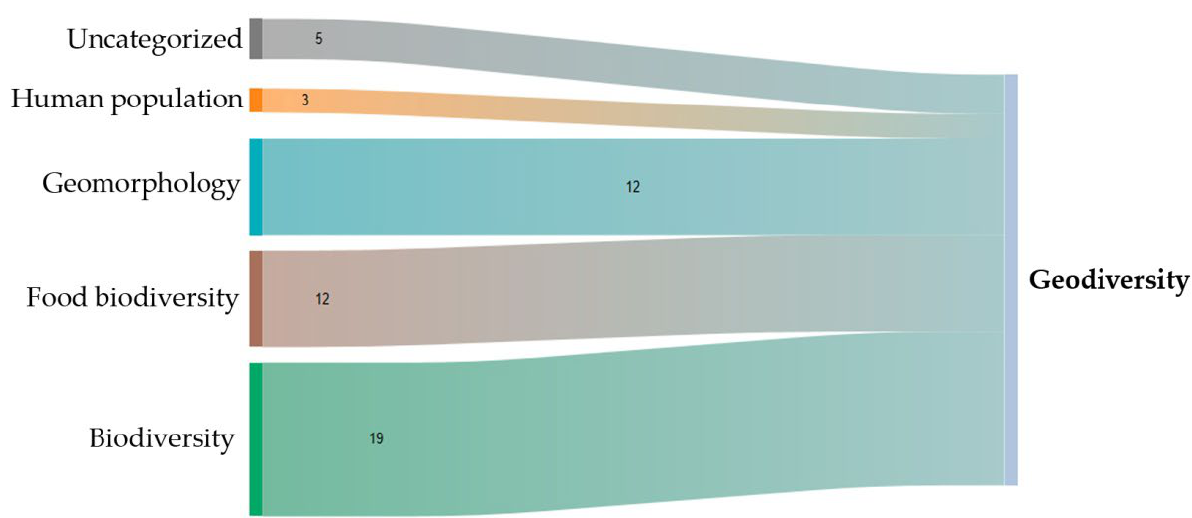
Figure 4. Graph of students’ perceptions (codes) on the concept of geodiversity (Sankey diagram).